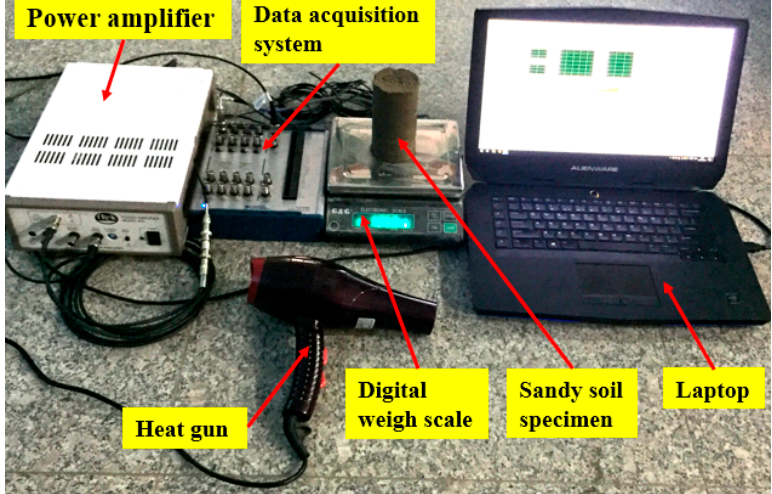
Figure 4. Experimental setup.